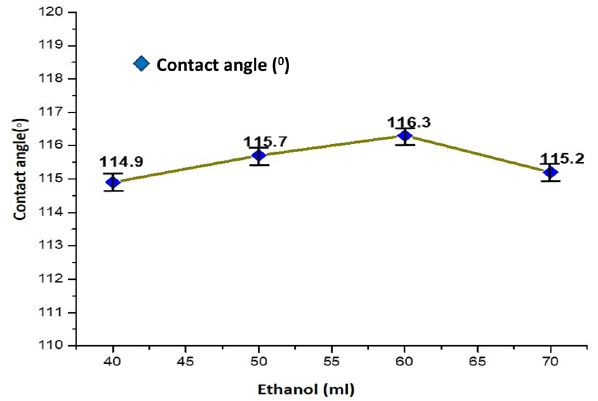
Fig. 13 A graphical demonstration of the influence of the amount of ethanol on contact angle